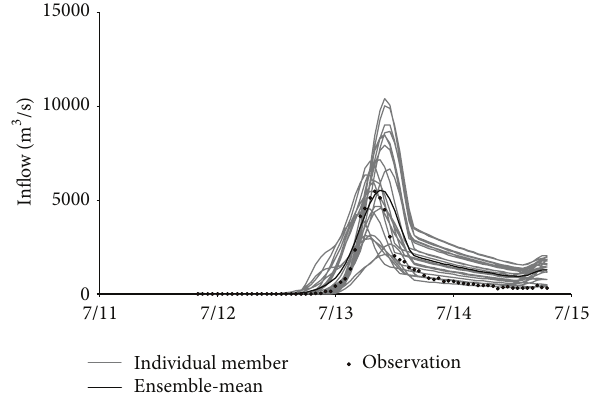
Figure 5: Example of 72 h reservoir inflow ensemble forecast for the Shihmen Reservoir from 20:00, July 11, 2013 to 19:00, July 14, 2013. This result was based on the TAPEX 78 h precipitation ensemble forecast from 14:00, July 11, 2013 to 19:00, July 14, 2013. The initial six hours were set as the warm-up time of simulation and were not included in the analysis. In addition, the gray lines represented hourly inflow forecast by each individual member. The black line represented the result by ensemble-mean of these 21 members.